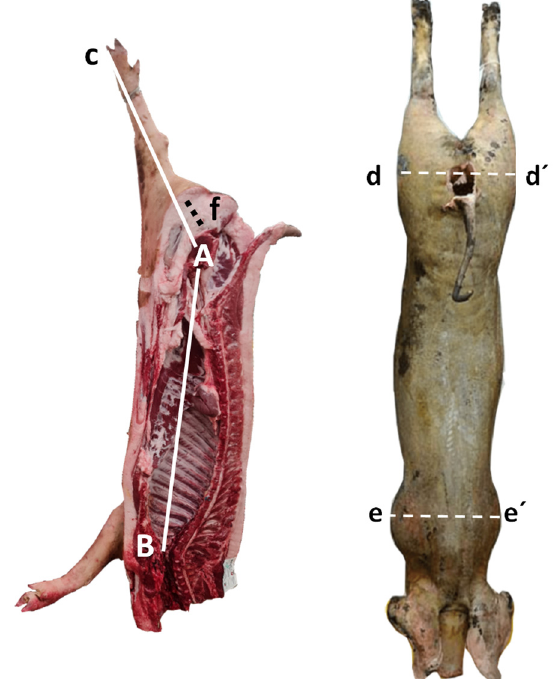
Figure 1. Schematic midsagittal and dorsal view of carcass measurements. (Midsagittal view) carcass length (L), A–B distance; leg length (LL), C–A distance. (Dorsal view) width of the buttocks d–d´ distance; width of the thorax, e–e ′ distance; leg fat thickness (f). Leg length (LL): distance from the tarsal–metatarsal joint surface to cranial edge of the pubic bone (Figure 1 midsagittal, A–C distance)